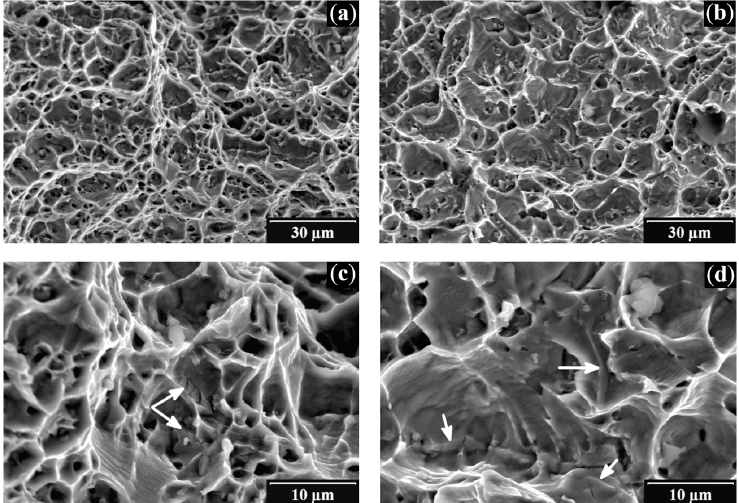
Figure 5. Fractographic features identified in two sites (( a , c ) and ( b , d )) of the fracture surface of the T4 specimen characterized by relatively high ductile tearing resistance, J 0.2 : micromorphology of classical ductile dimple fracture. Features of sparsely distributed cracked secondary particles could be identified on the fracture surface (marked by arrows in figures ( c , d )).